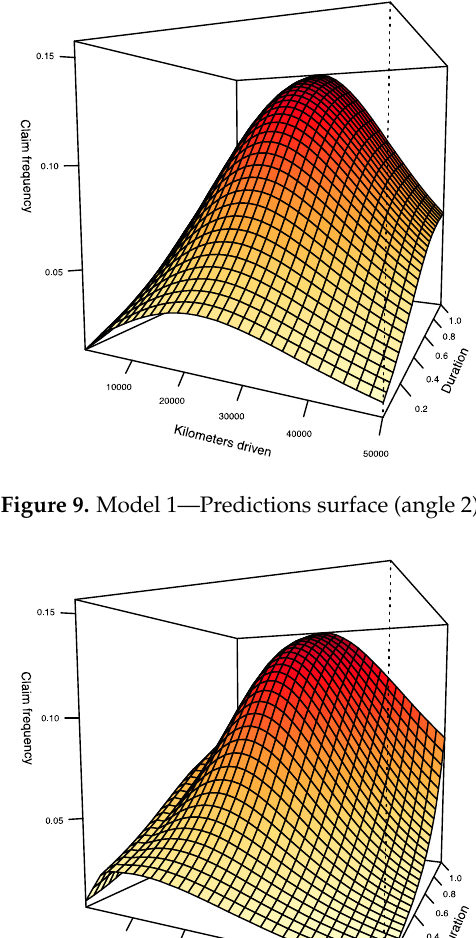
Figure 8. Model 2—Predictions surface (angle 1). Risks 2017 , 5 , 54